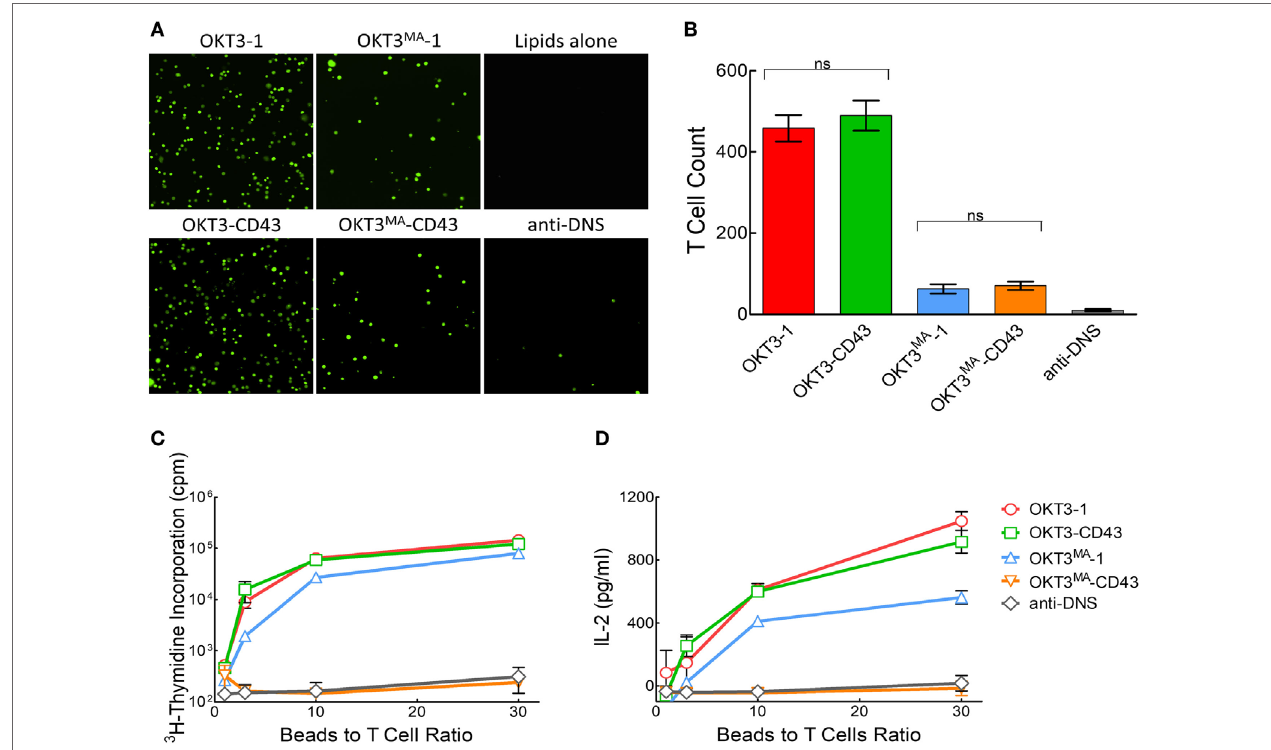
FigUre 2 | T cell activation by anti-CD3 scFv tethered to lipid bilayer-coated glass beads. (a) Fluorescent imaging of calcein-labeled Jurkat T cells binding to anti-CD3 scFv or control anti-DNS scFv tethered to planar lipid bilayer-coated glass surfaces. (B) Mean number of bound cells ( n = 8). Bars, SD. ns, not significantly different. (c) 2 × 10 5 primary human T cells were incubated with the indicated ratios of lipid bilayer-coated glass beads decorated with anti-CD3 scFv. Results show T cell proliferation as measured by 3 H-thymidine incorporation ( n = 4). Bars, SD. (D) IL-2 concentration after 48 h in wells containing 2 × 10 5 primary human T cells incubated with the indicated ratios of lipid bilayer-coated glass beads decorated with anti-CD3 scFv ( n = 3). Bars,